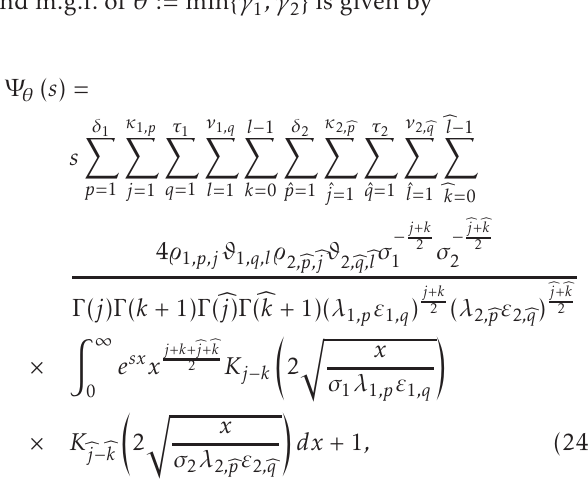
c 2 are the distance dependent power transfer factors for the source-destination, source-relay and relay- destination channels respectively. N 0 is the variance